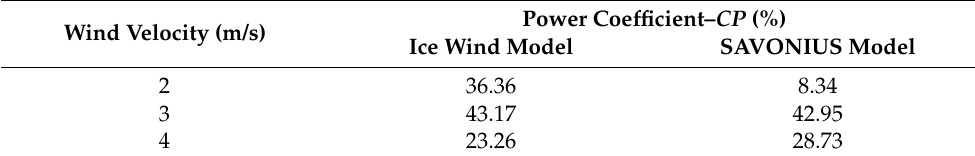
Figure 19. Torque values for the ice wind rotor versus the SAVONIUS rotor [87]. The CP values corresponding to the rotor models with aluminum blades are presented in Table 6, while the graphical representation is shown in Figure 20. Table 6. The power coefficient values for aluminum rotor models [87].